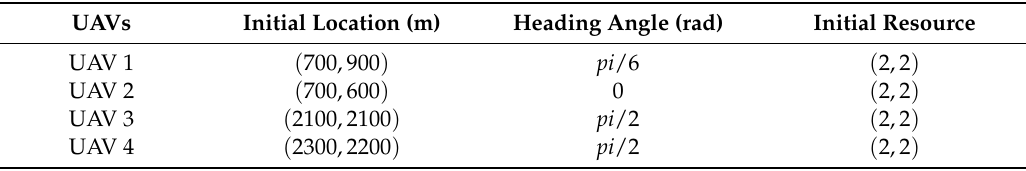
Table 4. Initial information of UAVs.